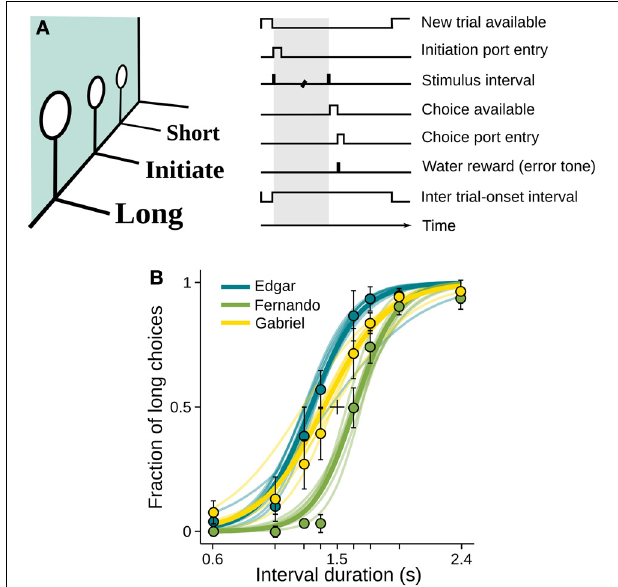
FIGURE 1 | Rats learned to categorize interval durations as short or long. (A) Animals interacted with three nose ports. Poking at the central port triggered a random stimulus interval (range: 0.6–2.4s; top right, shaded area). A water reward became available at the left port after intervals longer than 1.5s, and at the right port after shorter intervals. Wrong choices were punished with a brief white noise sound and a time out. (B) Psychometric functions show near perfect categorization of easiest stimuli (i.e., those far from the 1.5s categorical boundary), while performance approaches chance level for intermediate durations. Circles and whiskers are mean and standard deviation across sessions. Thin lines are logistic fits to single sessions. Thick lines summarize performance of each subject. Color code identify subjects and is maintained throughout the article. n = { 10 , 8 , 6 } sessions (rats Edgar, Fernando, and Gabriel, respectively; same for Figures 3 , 5 , 6 ); 346 ≤ n ≤ 558 trials per